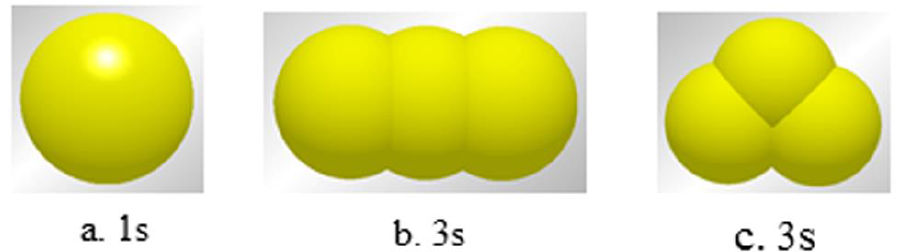
Figure 11. Representative types of actual soil particles.